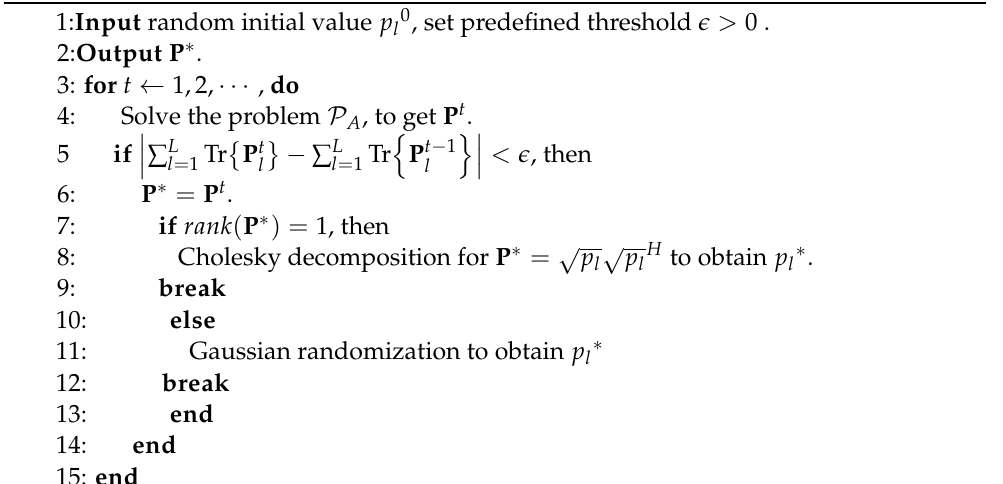
Algorithm 1: SDR Algorithm for Problem P A .